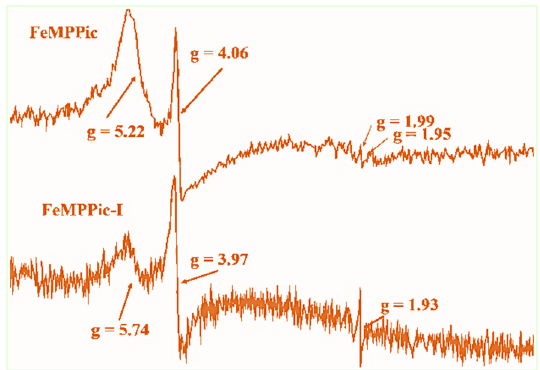
Figure 7. Top: ESR spectrum of [FeMPPic] at 77 K in methanol solution with two species of Fe(III) with qms; s = 3/2, S = 5/2, species with g = 5.22, 1.99 contains more s = 5/2 in qms; species with g = 4.06, 1.95, contains more s = 3/2 in qms. Bottom: [FeMPPic]-I with two species of iron ion, one with g = 5.74 and higher percentage of this species in qms but in less proportion than the second species (g = 3.97) with s = 3/2. At g = 1.93 the radical signal is present. Table 3. ESR spectra data of compound I and compound II intermediates of peroxidases and peroxidase models, contrasting the chemical shifts for [pinch porphyrinsFe IV =O] +· presented in this work.